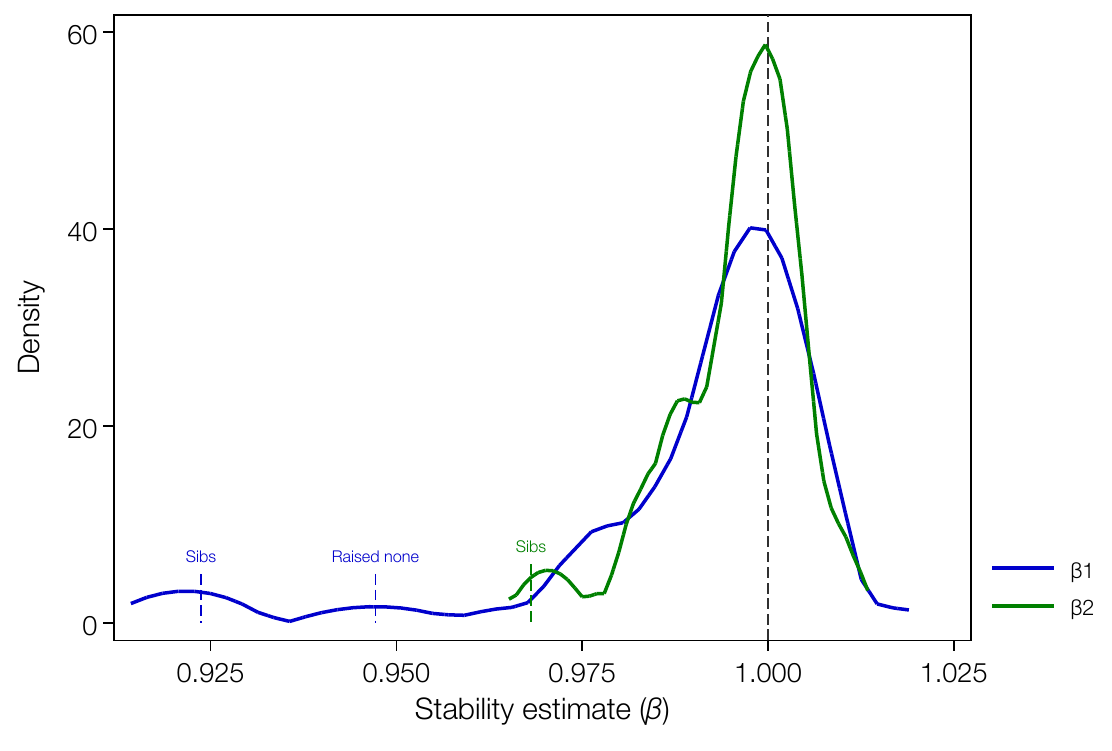
Figure 2: Kernel density curves for stability estimates between the first and second waves ( β third waves ( β 2 ) for relatively fixed